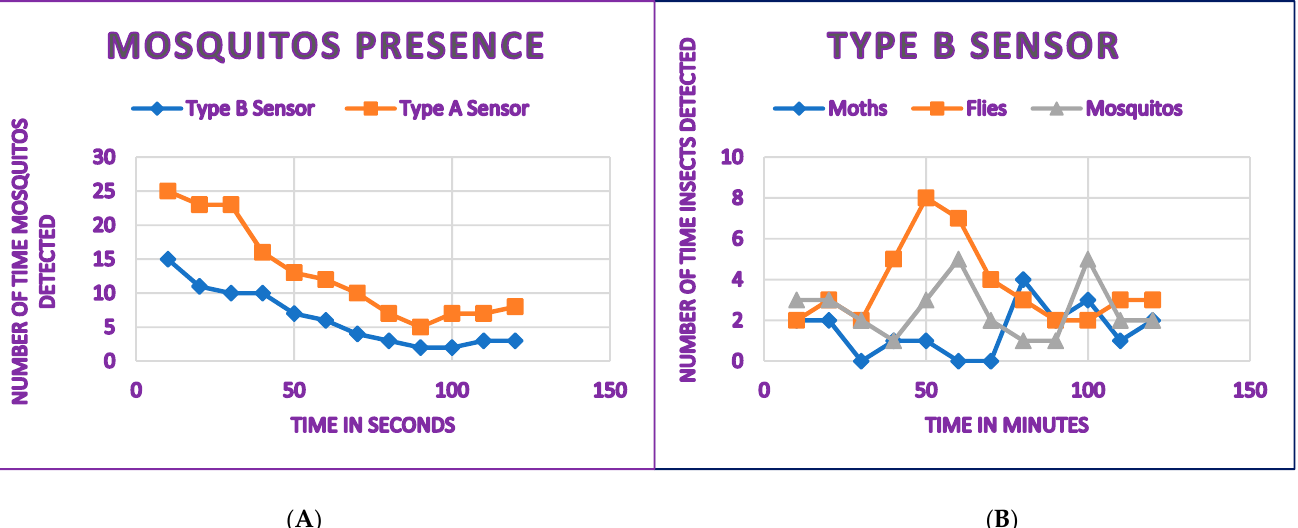
Figure 8. ( A ) Mosquito detection in a controlled environment. ( B ) Three types of insect detection through B sensor prototypes. (Numbers are every 10 min).